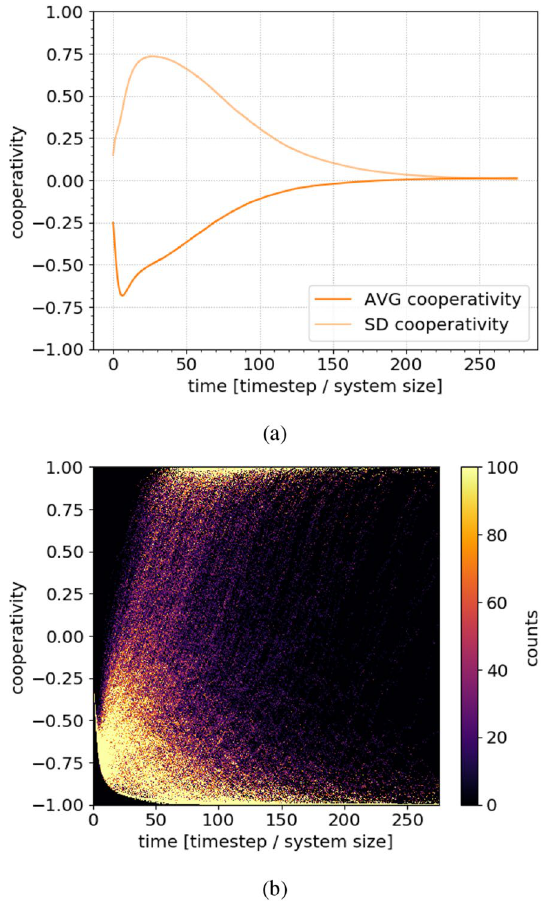
Figure 2. Long-term evolution of a system close to a tipping point ( φ = 0.0103 ). ( a ) The average and standard deviations of the cooperativity converge to a value near zero, meaning that in roughly half of the realizations, the networks became completely cooperative, and in the other half, completely defective. This evolution is very sensitive to changes in parameter values around this point, as is a hallmark of tipping points. ( b ) A heatmap corresponding to all the data for which the averages are shown in ( a ). The intensity corresponds to the density of networks having a specific average cooperativity at a specific time. Most networks converge to full cooperation or defection within the simulation time, reinforcing that this is a tipping point.